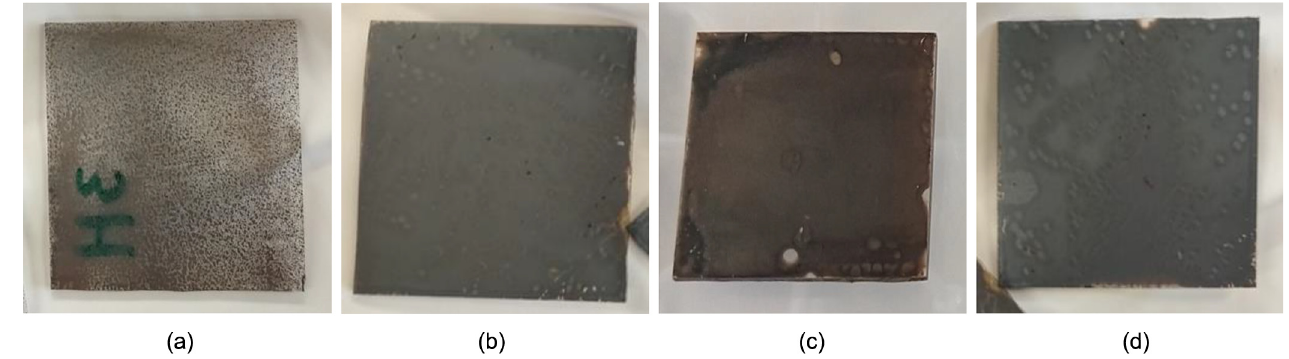
Fig. 1. Ultrasonically spray coated perovskite samples. Heterogeneous coverage as result of high processing temperature and absence of NMP (a). Opaque layers as result of slow solvent